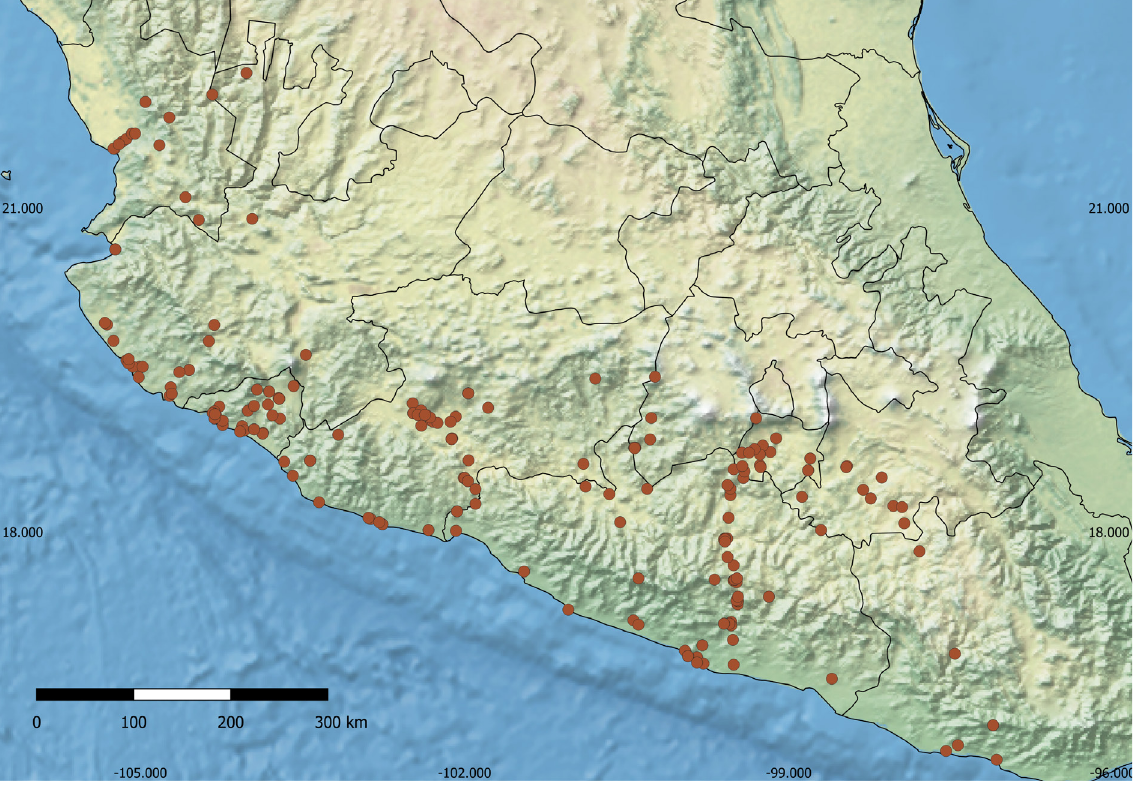
Fig. 4. Locality records of Salvadora mexicana (Duméril, Bibron &